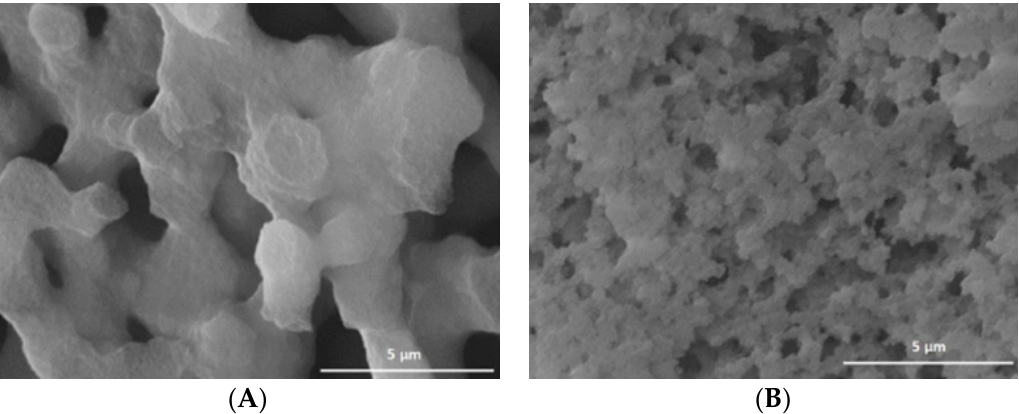
Figure 1. SEM micrographs (20000×) of Mono-ICE before ( A ) and after calcination ( B ). The Mono-ICE sample after the spinodal phase separation process (Figure 1A) is characterized by an irregular morphology, where the particle aggregation gives origin to interconnected macropores with a diameter of 4 µ m and a skeleton thickness of 3 µ m, on average, in accordance with what it has been reported in the reference article [4]. After the formation of the macroporous monoliths in acidic medium at low temperature, the ammonia treatment at 40 ◦ C brings about the rearrangement of the weakly condensed silica network into denser nanodomains and the formation of larger mesopores, giving rise to the final hierarchical SBA-15 [4]. After the calcination of the organics (Figure 1B), the sample morphology appears deeply modified, with a strong reduction of macropore dimensions to 0.5–1 µ m, on